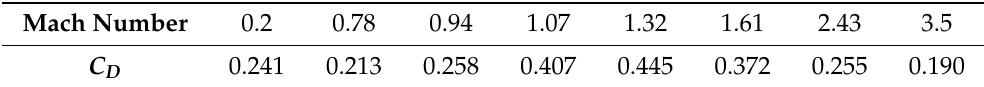
Table 2. Drag coefficient.